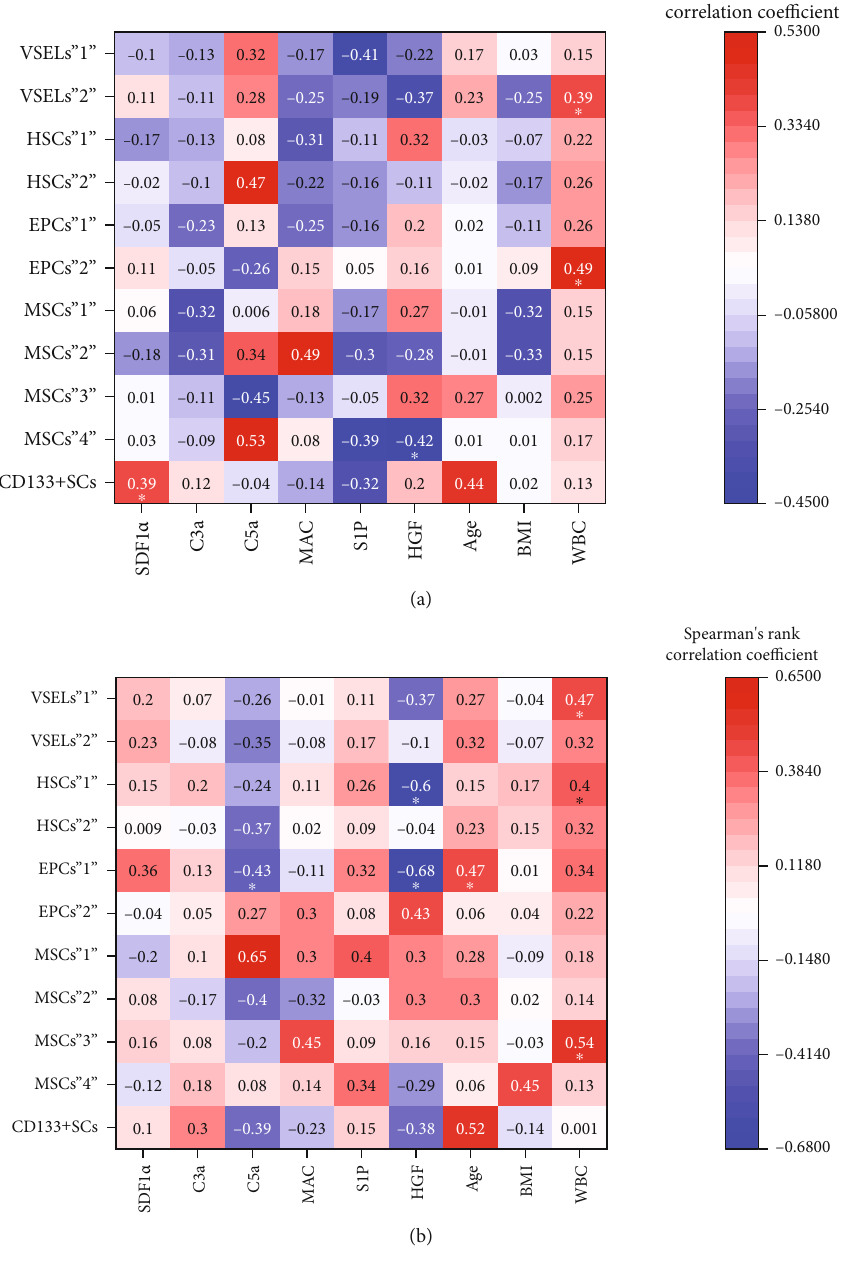
Figure 6: Heatmaps of the Spearman rank correlation coe ffi cients between circulating populations of BMSCs and the concentration of chemoattractive factors or general patient characteristics. (a) AP group. (b) CP group. ∗ P < 0 : 05